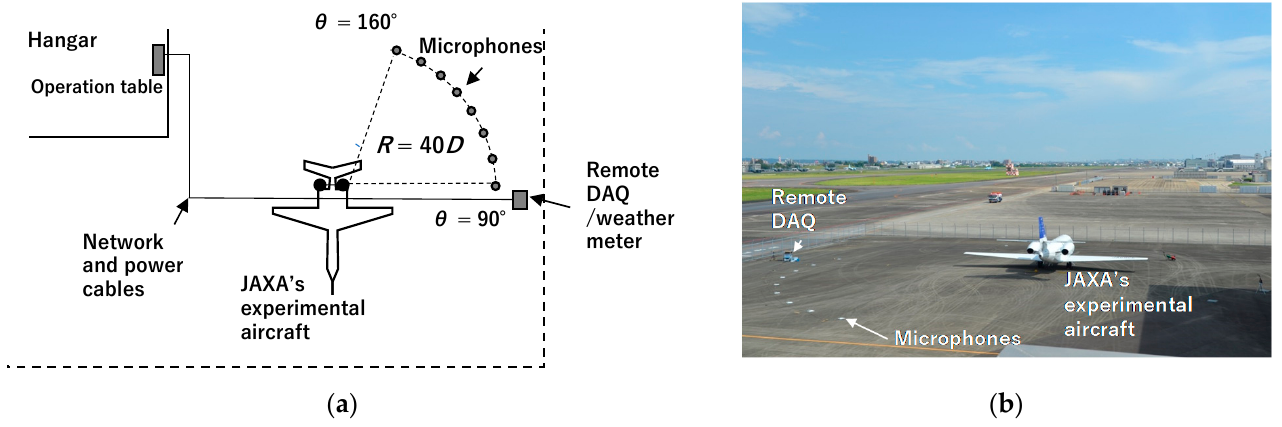
Figure 6. Experimental setup of ground noise measurement tests using JAXA’s experimental aircraft: ( a ) schematic diagram of the layout of the instruments; ( b ) photograph of the test field.